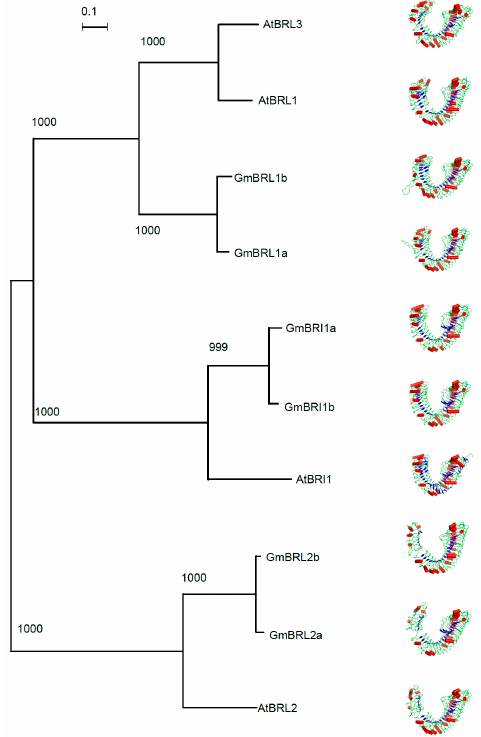
Figure 9. Structural modeling of six soybean BR receptors. The program PhyML3.0 [58] was used